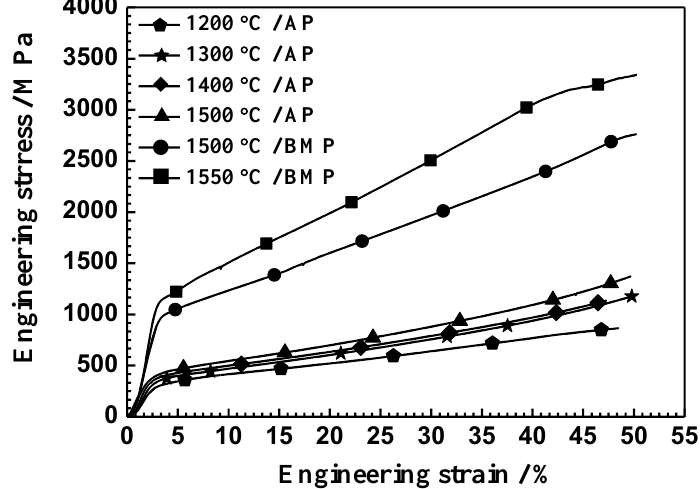
Figure 7. Compressive stress – strain curves of Ti-28Nb-35.4Zr alloy prepared with different sintering temperatures and powders.